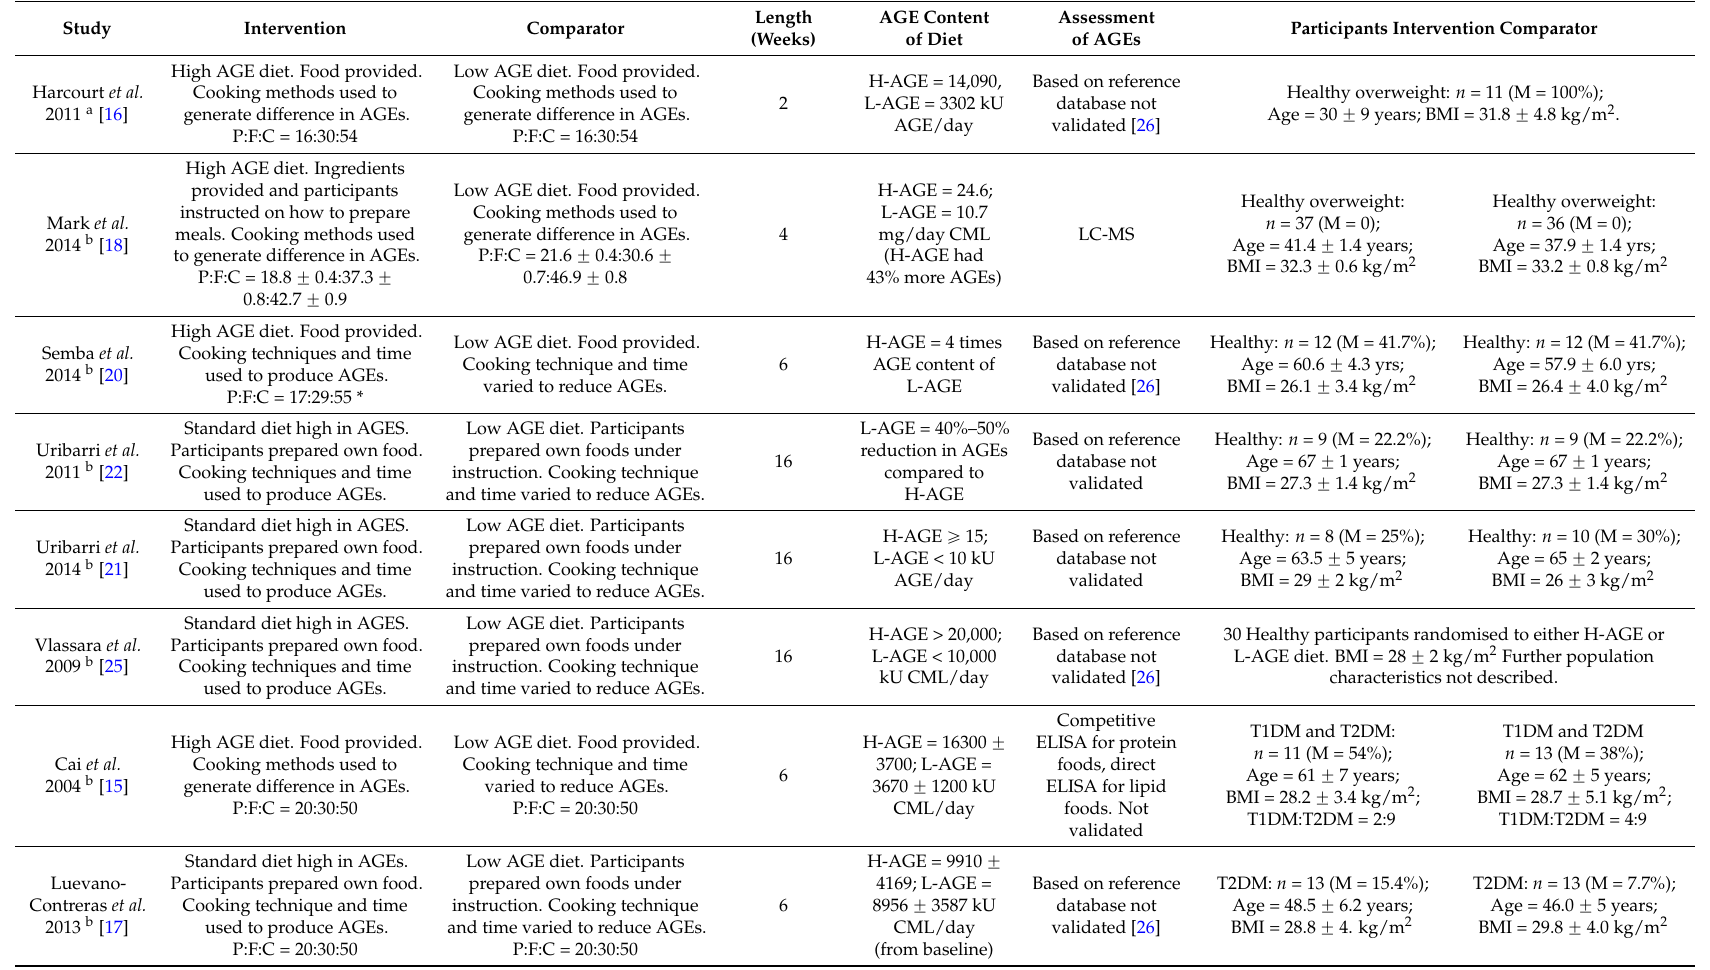
Table 1. Characteristics of included dietary